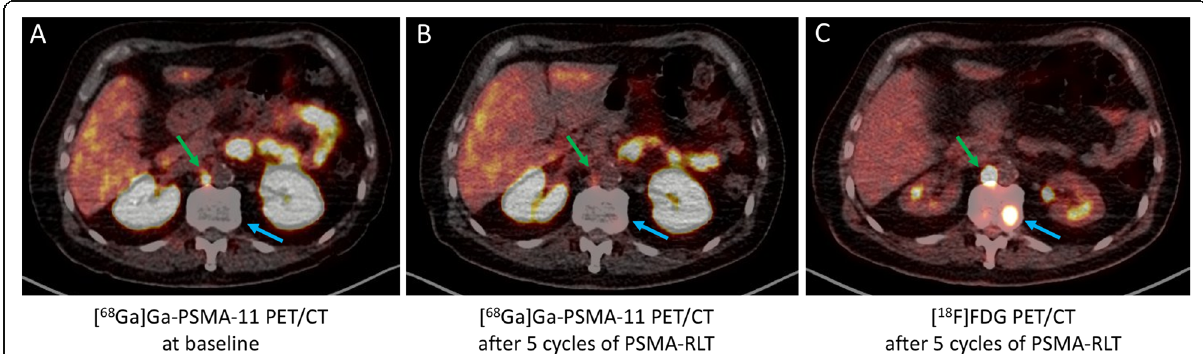
Fig. 2 Example of two mismatch lesions detected after 5 cycles of PSMA-RLT: one intensely PSMA-positive (green arrow) and one not identifiable (blue arrow) lesion on the initial [ 68 Ga]Ga-PSMA-11 PET/CT at baseline prior to PSMA-RLT ( a ). [ 68 Ga]Ga-PSMA-11 PET/CT ( b ) and [ 18 F]FDG PET/CT ( c ) after 5 cycles of PSMA-RLT showing [ 18 F]FDG/[ 68 Ga]Ga-PSMA-11 mismatch in both lesions